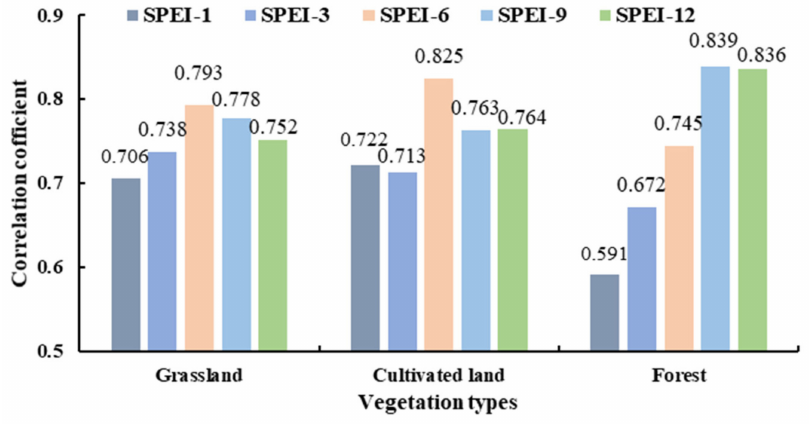
Figure 7. Maximum correlation coefficient between NDVI and SPEI for different vegetation